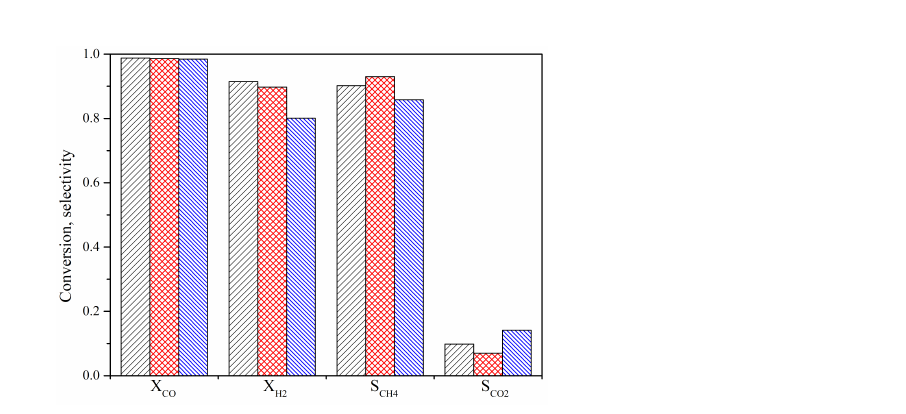
between gas and solid is nearly the same for the case with normal arrangement and volume fraction as shown on the right of Figure 15, the staggered tubes lead to a lower different performances of the reactor.